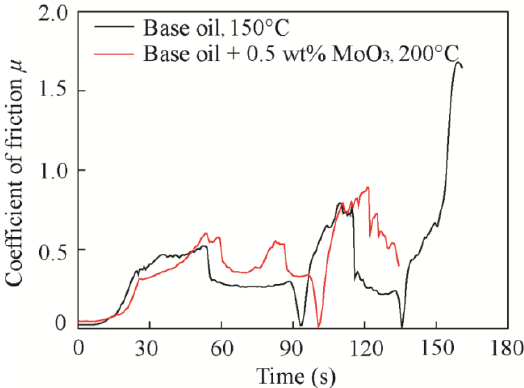
Figure 13. Typical friction coefficient curves at the critical temperature.